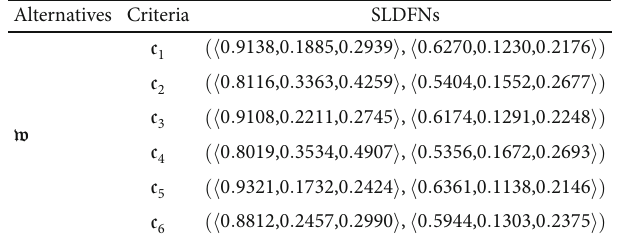
Table 6: Aggregated SLDF criteria weight